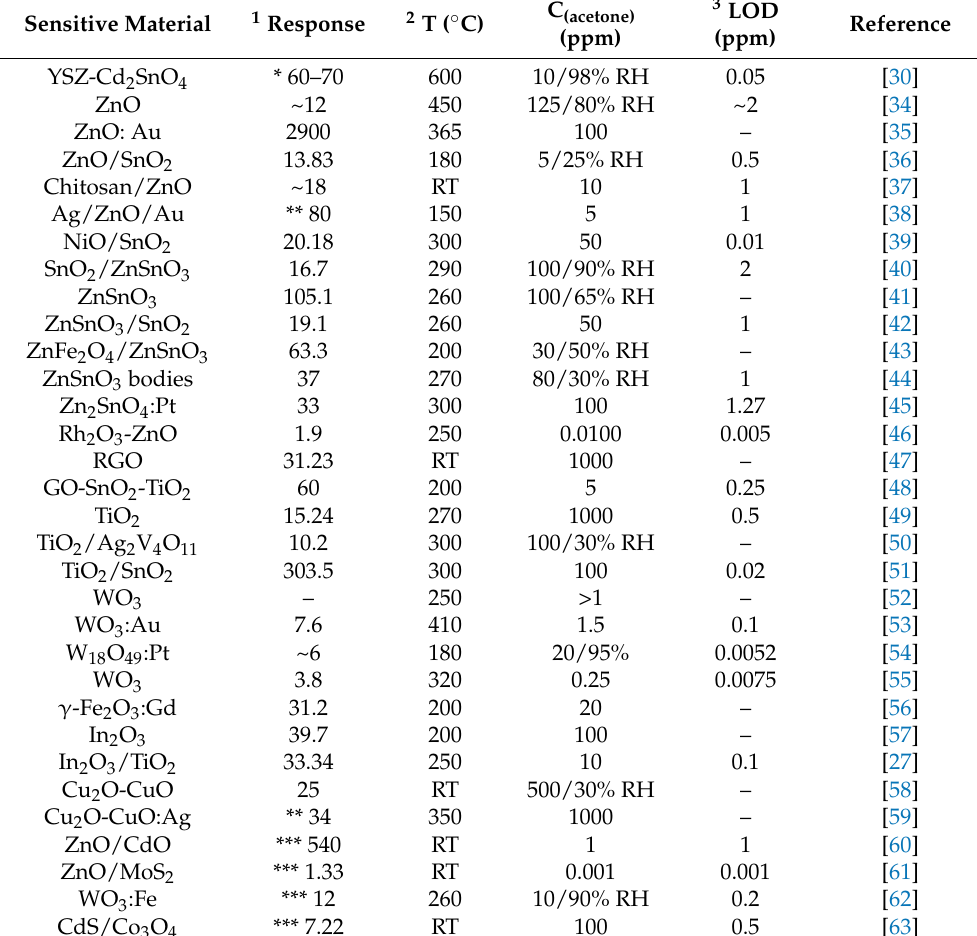
Table 1. Summary of the literature review of selected metal oxide-based sensors for acetone detection published between 2019 and